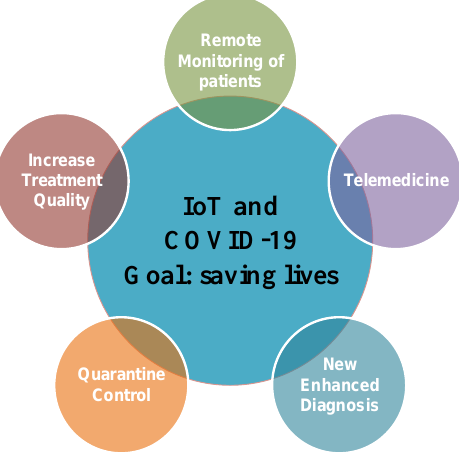
Figure 1. Advantages of using IoT for COVID-19 pandemic monitoring.